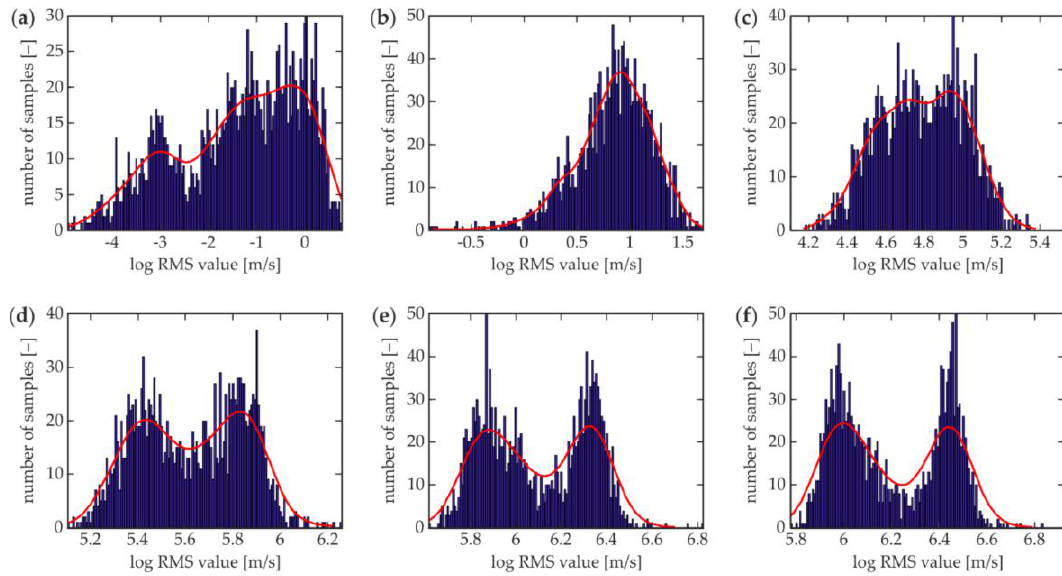
Figure 15. Histograms of WRMS values ( w r = r 2 ) for specimen #5 with different time windows: ( a ) T = 0.03 ms; ( b ) T = 0.05 ms; ( c ) T = 0.50 ms; ( d ) T = 1.00 ms; ( e ) T = 2.00 ms; and, ( f ) T = 3.00